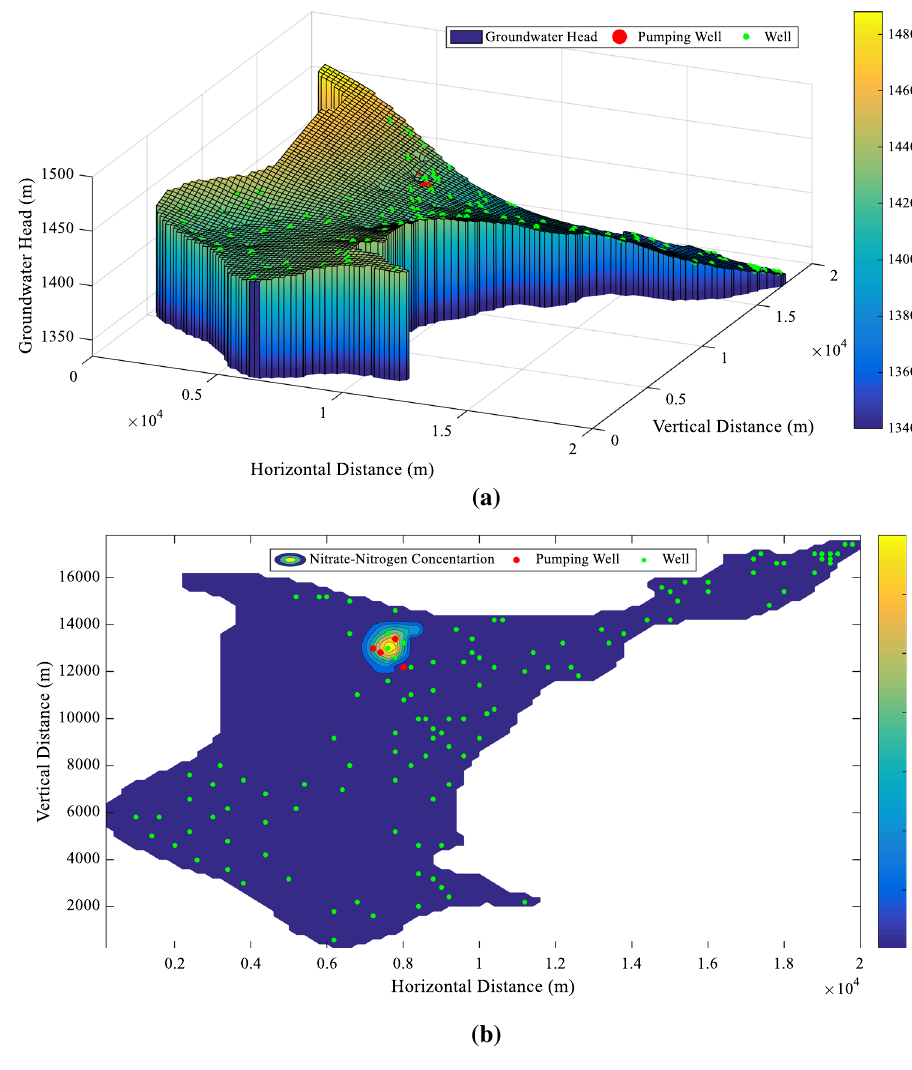
Fig. 16 Selected solution a Groundwater head, b contami- nant